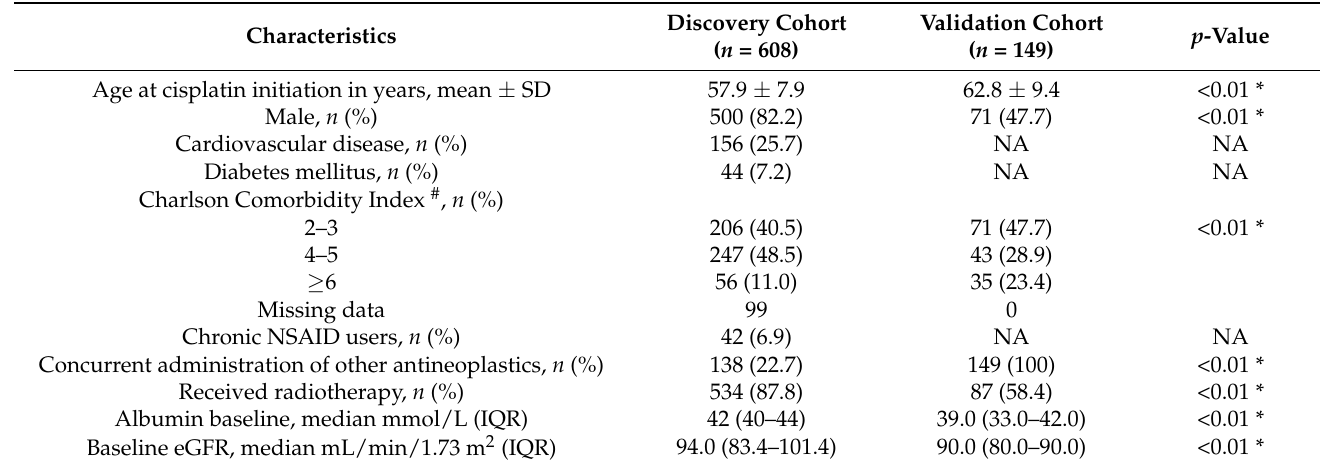
Table 1. Demographic and clinical